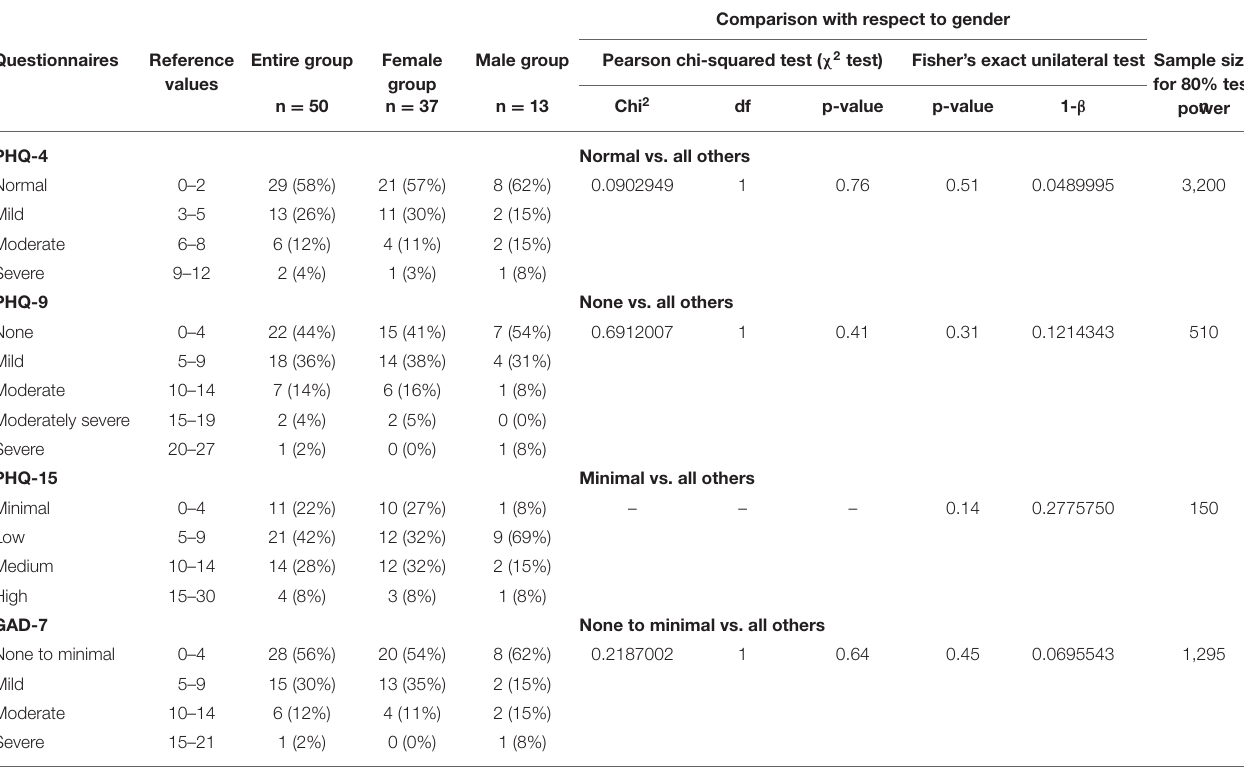
TABLE 4 | Health status with respect to the patient health questionnaires (PHQ-4, PHQ-9, PHQ-15) and generalized anxiety disorder (GAD-7) in the entire study group (n = 50), the female group (n = 37) and the male group (n = 13).